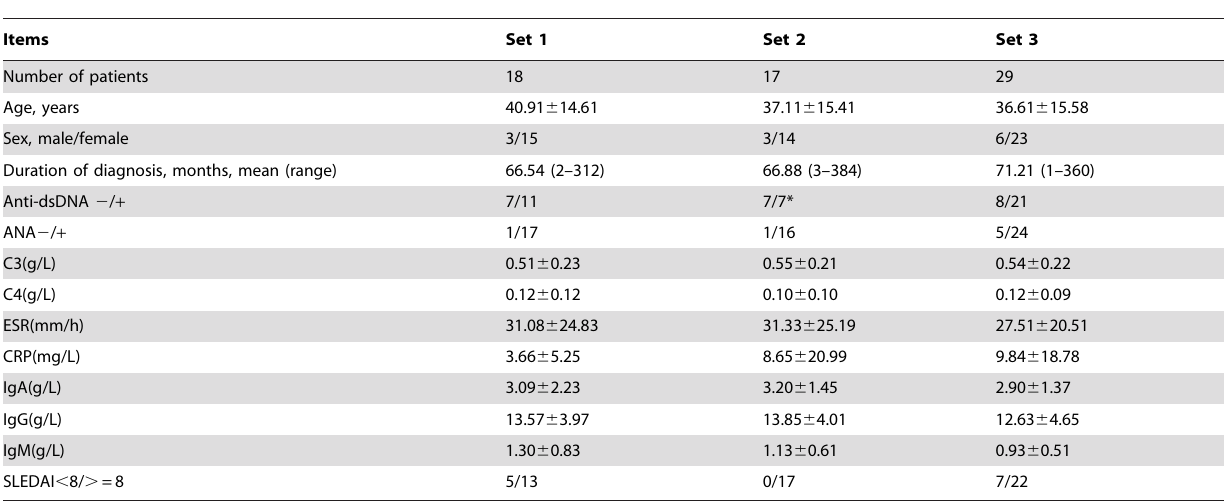
Table 1. Clinical characteristics of SLE patients studied.